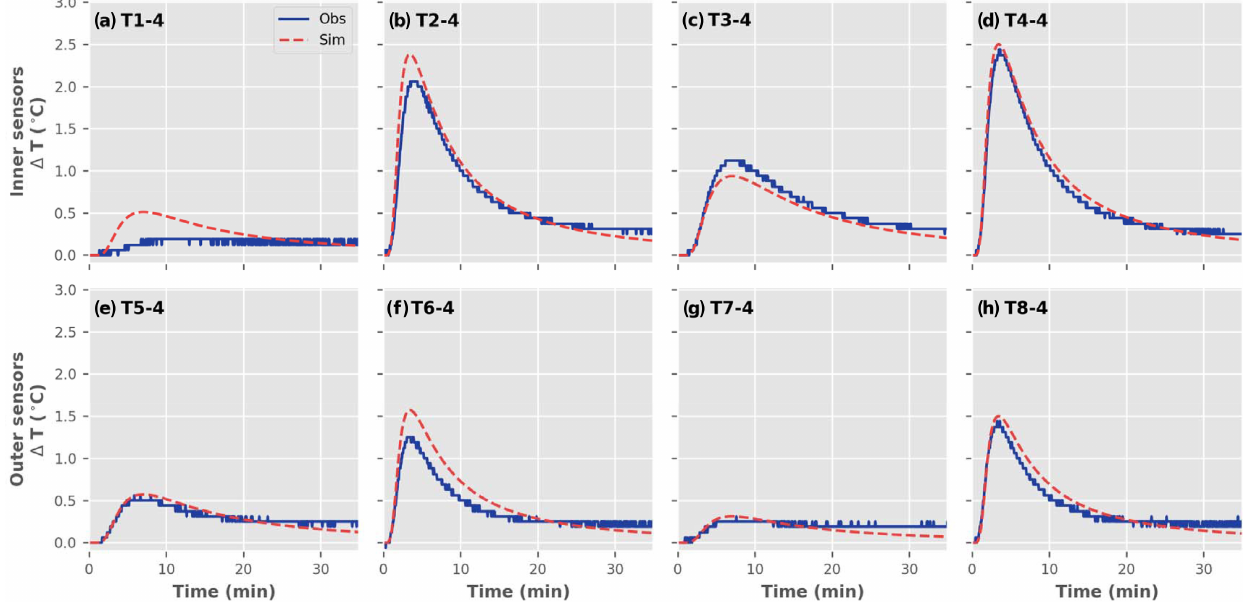
Figure 4. Breakthrough curves shown of the fourth vertical thermistor (158mm depth) from each radial sensor location for the horizontal flow scenario from heat injection depth at relay 2. Solid lines are observed and dashed lines are